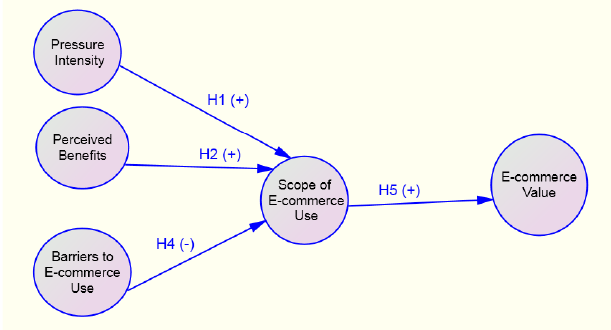
Figure 2:Revised structural model of e-commerce value Measurement